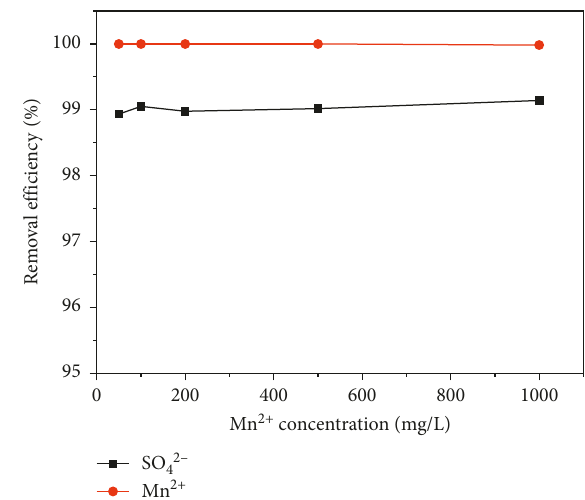
Figure 10: The effect of Mn 2+ concentration. V Al :S) 4:1 :1, v (cid:27)